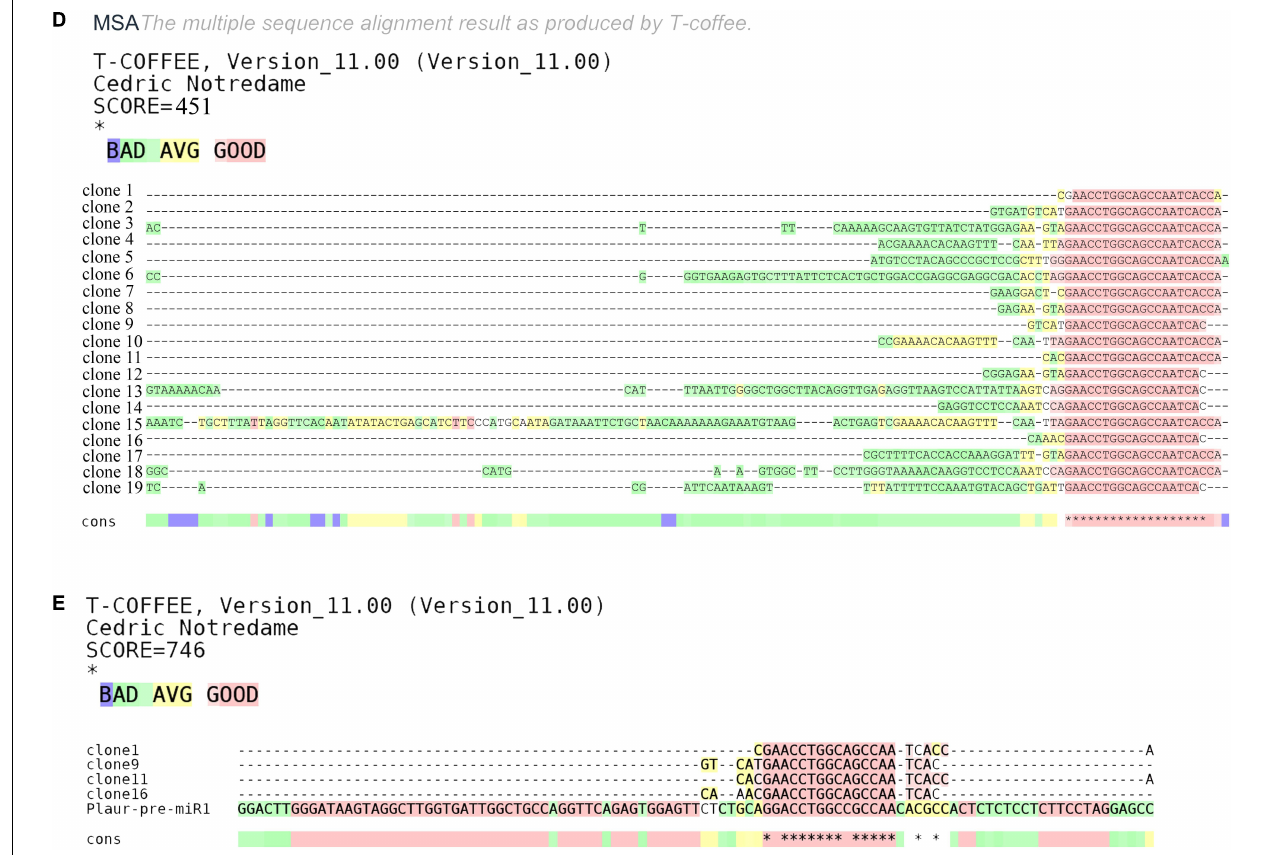
FIGURE 4 | Analysis of Plaur-miR1-3p and Plaur-miR1-5p expression in Neuro2a cells and mouse posterior cortex. (A) qPCR of Plaur-miR1-3p and Plaur-miR1-5p expression in Neuro2a cells. The data are expressed as mean ± SEM ( n = 3), normalized to Snord95 expression as a reference gene. (B) qPCR of Plaur expression in Neuro2a cells. The data are expressed as mean ± SEM ( n = 3), normalized to Actb (encodes β -actin) expression as a reference gene. For (A,B) , the columns are: Neuro2a WT—control Neuro2a cells; Neuro2a-KO-uPAR—uPAR-deficient Neuro2a cells; Neuro2a Plaur-miR1—Neuro2a cells with ectopic Plaur-pre-miR1 expression; Neuro2a-KO-uPAR Plaur-miR1—uPAR-deficient Neuro2a cells with ectopic Plaur-pre-miR1 expression. The data were analyzed by using analysis of variance followed by Dunnett’s multiple comparisons test using GraphPad Prism software. (C) qPCR of Plaur-miR1-5p and Plaur-miR1-3p in the posterior cortex 0 and 3 h after endogenous Plaur induction. The data are expressed as mean ± SEM ( n = 4). The data were analyzed by using a one-sample t -test with GraphPad Prism software. Statistical significance in (A–C) is indicated by bars and asterisks as follows: ∗ p < 0.05; ∗∗ p < 0.01; ∗∗∗ p < 0.001. (D) Sequence results of 19 TA vector clones containing Plaur-miR1-5p sequences generated in (C) . Four of 19 (20%) clones were 22–24 bp in length and could correspond to mature miRNA. In addition, 8 of 19 (40%) clones were 22–31 bp in length and could correspond to other RNA fragments isolated from posterior cortex small RNA